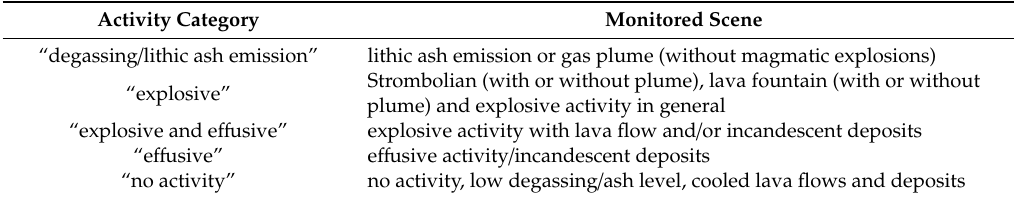
Table 2. Main activity categories and scenes outputted by the DT classifier.